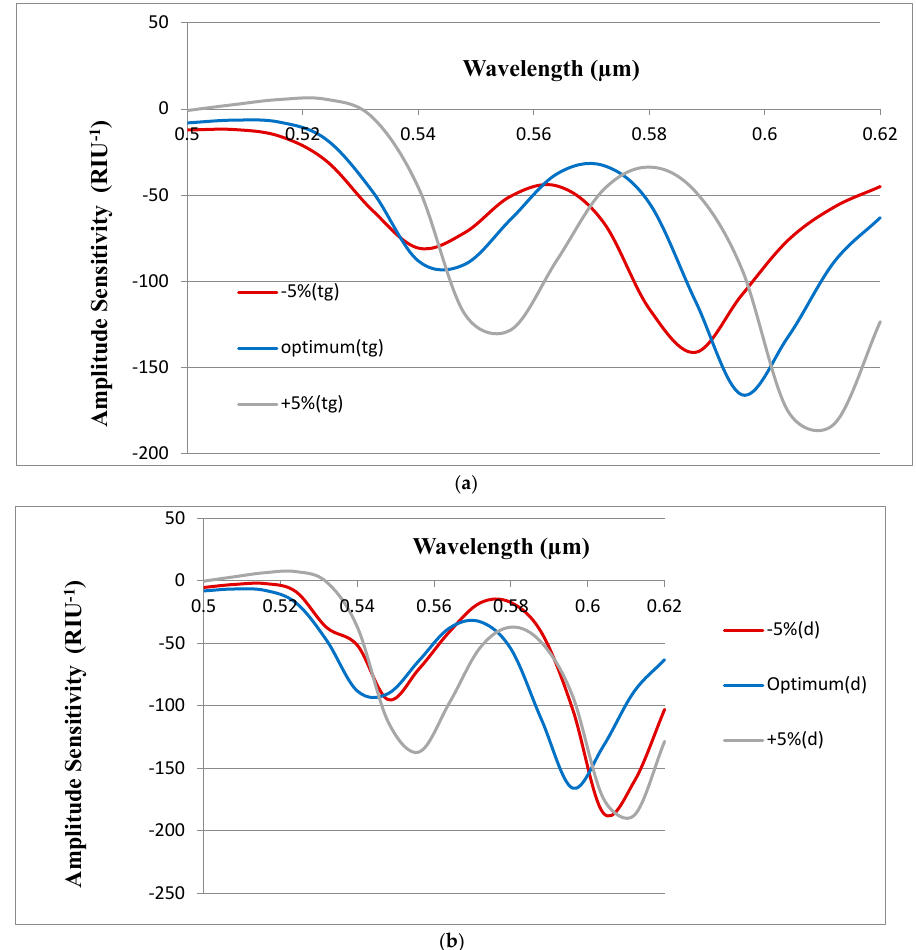
Figure 7. Fabrication tolerance analysis of the proposed sensor within a tolerance of ±5% of the ( a ) tg, and ( b ) d.